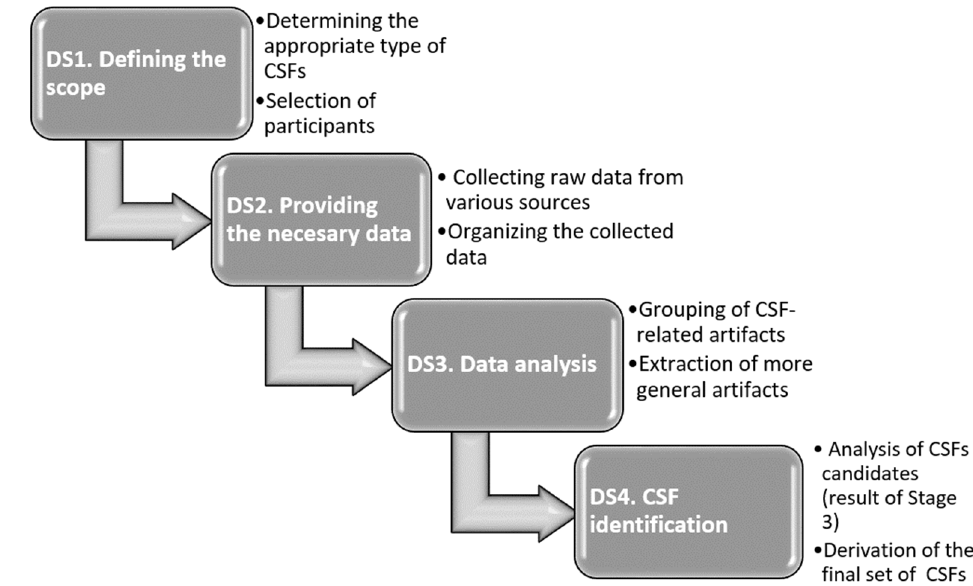
Figure 6. D esign of CSFs: Stages 1–4. Figure 6. Design of CSFs: Stages